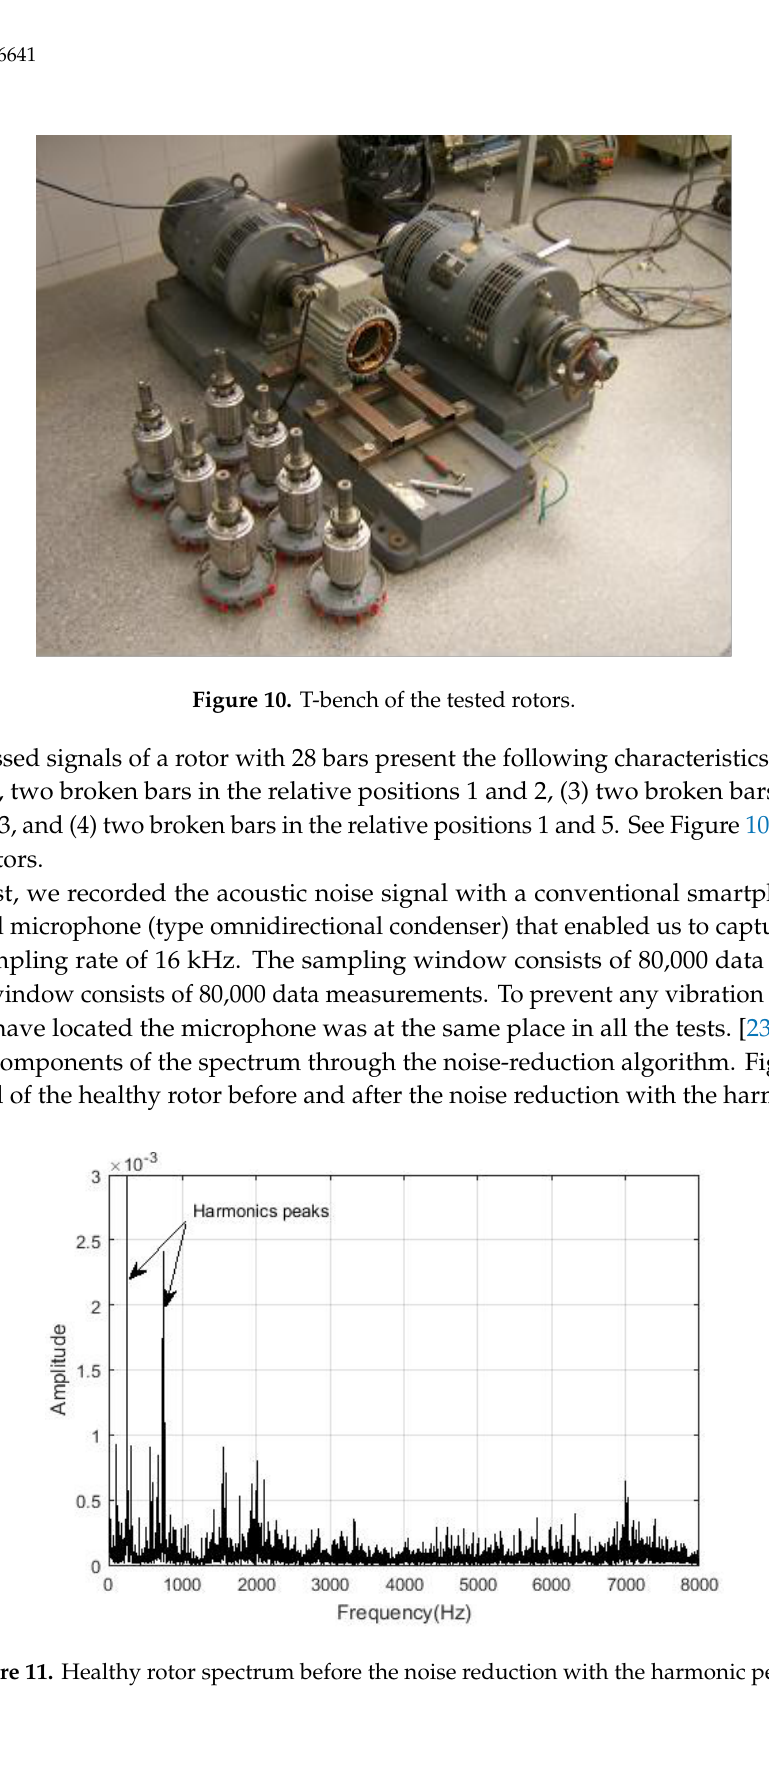
Figure 12. Healthy rotor spectrum after the noise reduction with the harmonic peaks. We show the results of the one broken bar signal. In Figures 13–15, we show the signal spectrum before and after the noise reduction. With zoom in the range of 500–1200 Hz we see a third harmonic that has not appeared in the healthy signal in Figure 11. To solidify the finding of the increment of harmonic peaks on the broken bar signals, we have also looked for it in the rest of the two broken bar signals.